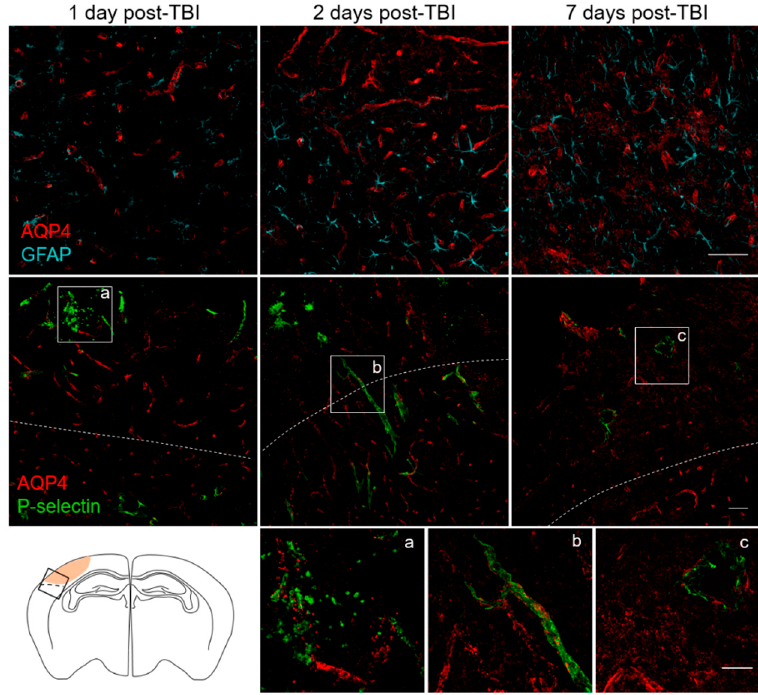
Figure 4. Spatiotemporal distribution of P-selectin in relation to perivascular changes in the acute phase post-TBI. Representative immunofluorescence images for AQP4/GFAP or AQP4/P-selectin staining 1, 2 and 7 days post-TBI at the contusion edge. The white dotted line defines the border between the contusional (upper part of the image) and pericontusional (lower part of the image) tissue, as shown in the sketch. Scale bar 50 µm. Panels a-c are magnification of the AQP4/P-selectin stained areas indicated in the white boxes. Scale bar 25 µm.